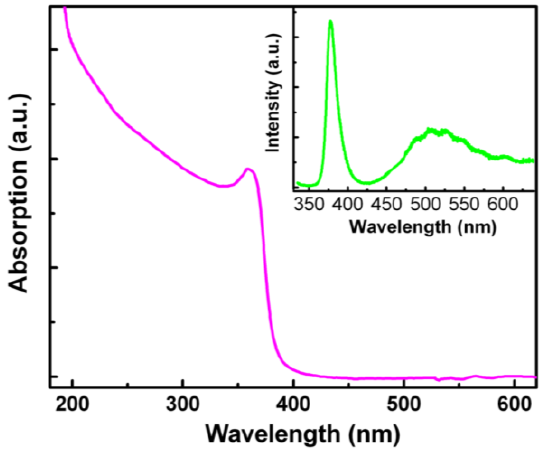
spectrum of the ZnO